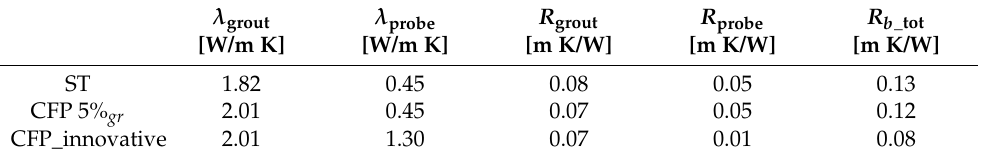
Table 5. Calculated thermal resistance ( R b ) for a 250 m borehole filled with standard and innovative grout.